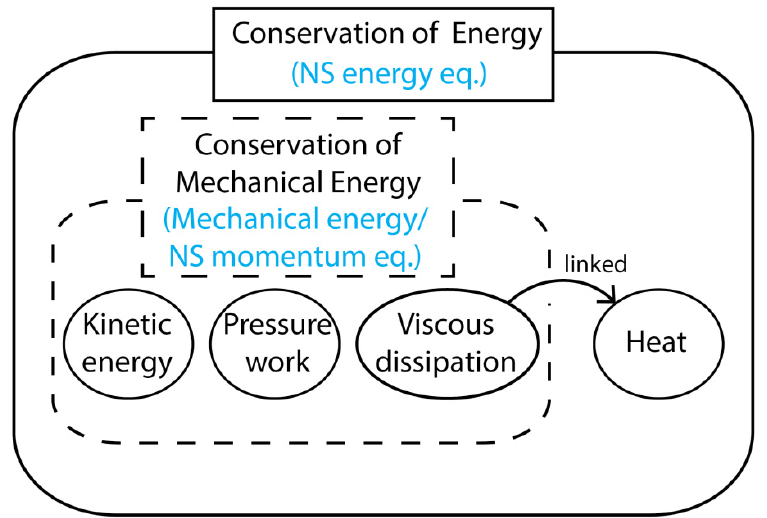
Figure 2. The diagram of the conservation of mechanical energy and total energy [23].